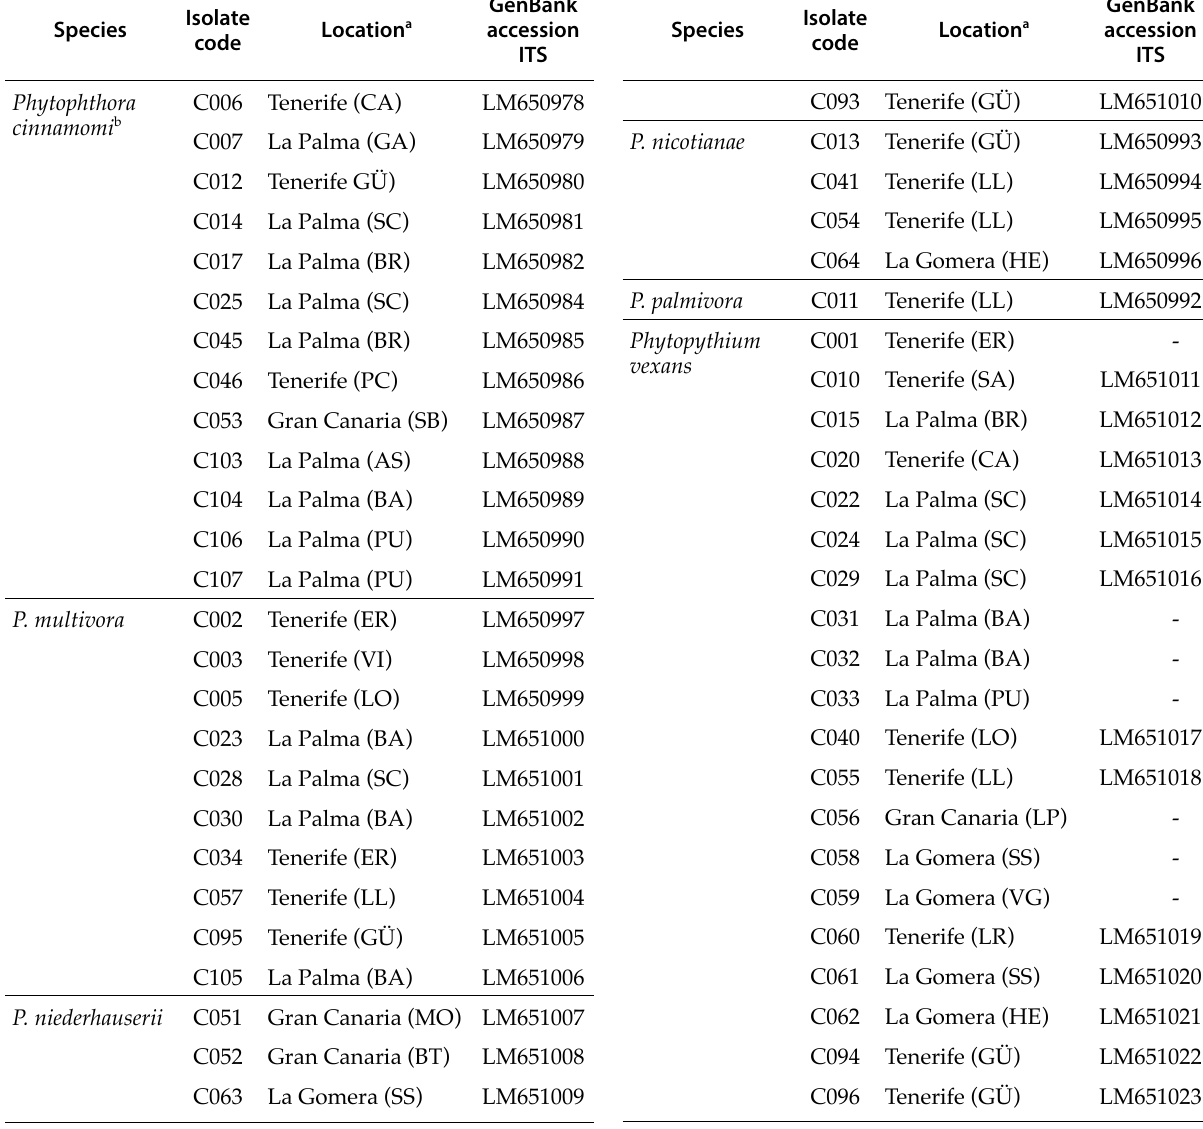
a See Table 2 for abbreviations. b A total of 26 P. cinnamomi isolates were identified morphologically and by PCR using the P. cinnamomi -specific primer pairs LPV2 and LPV3; a subset of 13 of these isolates had their ITS regions subsequently